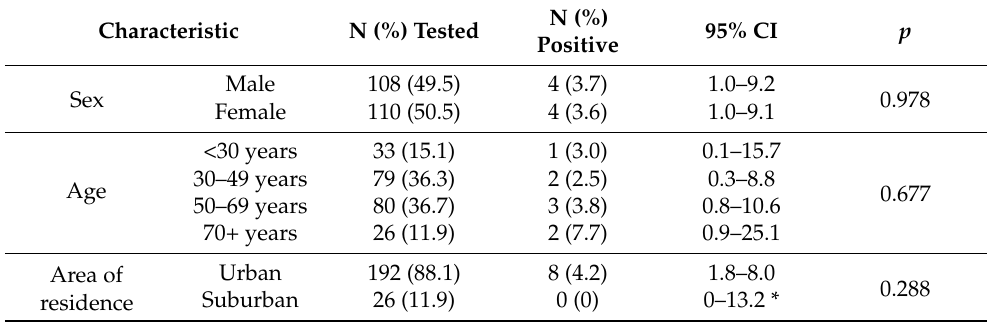
Table 2. Tahyna virus seroprevalence in asymptomatic individuals according to demographic